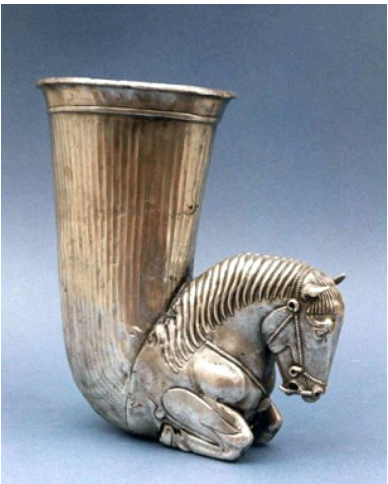
Figure 6. Vessel in shape of horse’s head (MMA acc. no. 47.100.87); rhyton, gilded silver; Iran;